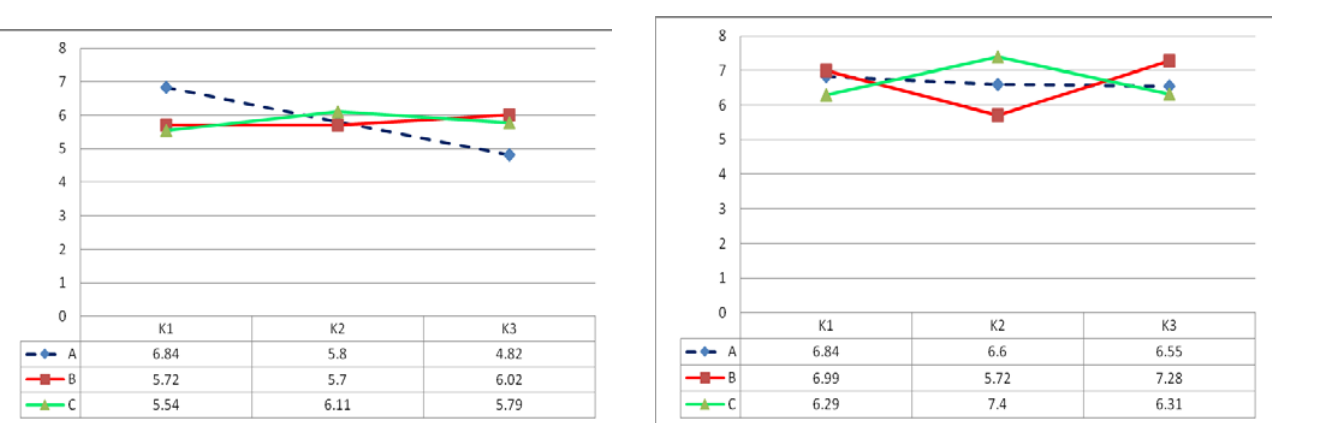
Figure 4: Relationship between the factors, the levels, and the K values (steel